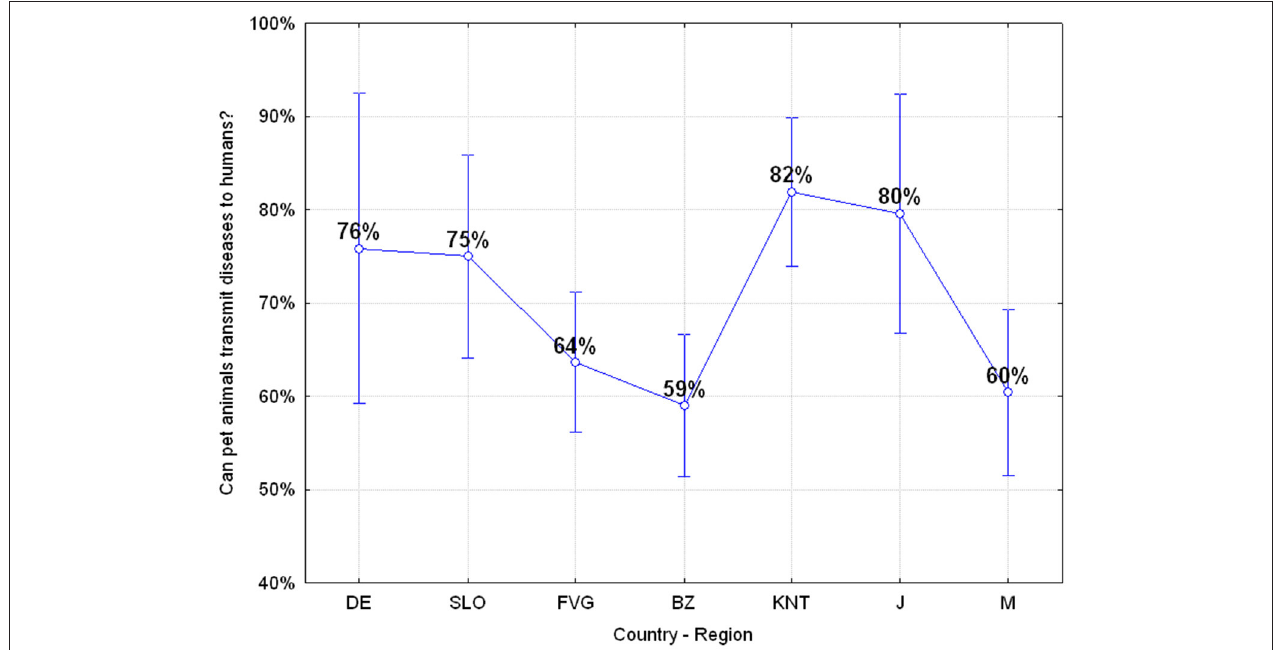
FIGURE 10 | Q24: “Can pet animals transmit diseases to humans?” ANOVA F (6,649) p = 0.00020 [Axes X regions or countries, Axes Y % correct answers–DE, Germany; SLO, Slovenia; FVG, Friuli Venezia Giulia Italy; BZ, Autonomous Province of Bolzano Italy; KNT, Carinthia Austria; J, Japan; M, Mauritius–( n = 656)].